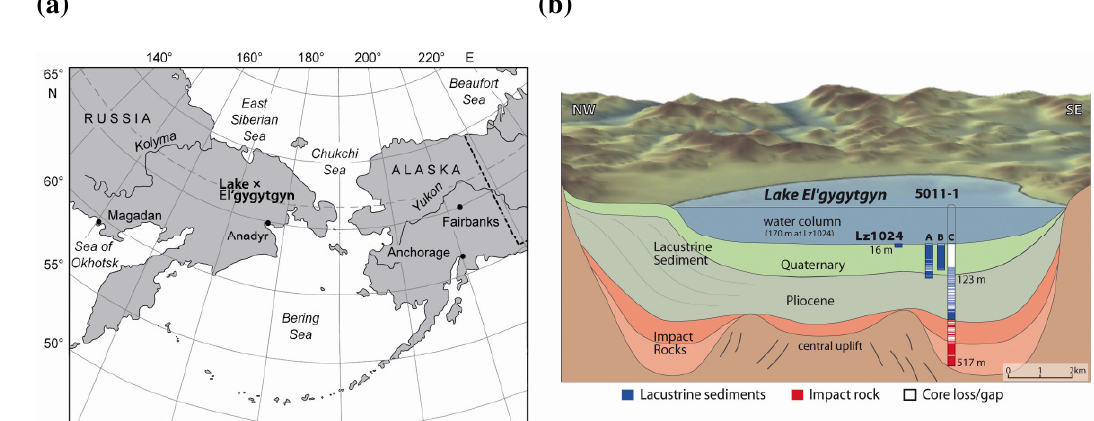
Fig. 1. (a) Geographical position of Lake El’gygytgyn and (b) drilling locations (Melles et al., 2011).